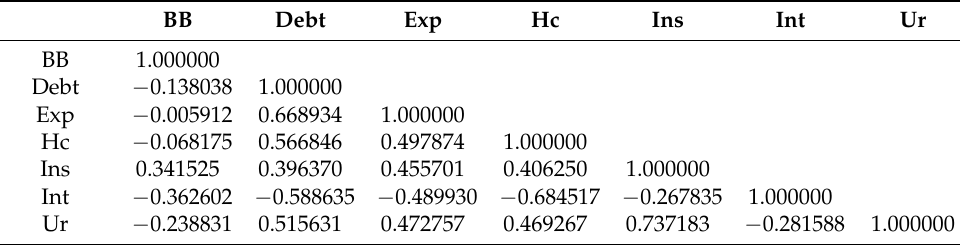
Table 5. Correlation matrix of the variables BB, mortgage, rent, utility bills or hire purchase arrears (Debt), inability to face unexpected financial expenses (Exp), income insecurity (Ins), household consumption (Hc), unemployment rate (Ur), and internet users (Int) for EU-ALL.